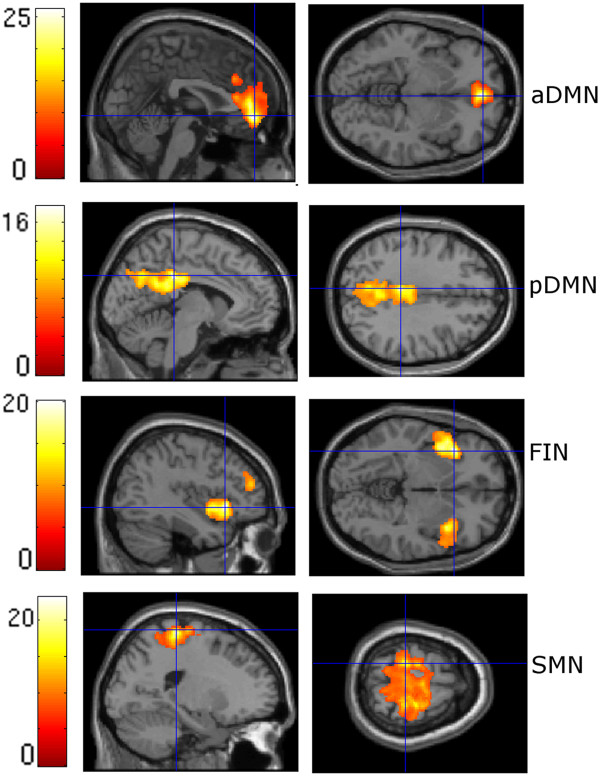
ICNs of the control group. For illustration purposes, spatial maps were thresholded at P = 0.05, corrected for family wise error (FWE) with a cluster extent threshold of 50 voxels; aDMN = anterior default mode network, pDMN = posterior default mode network, FIN = fronto-insular network, SMN = sensorimotor network.